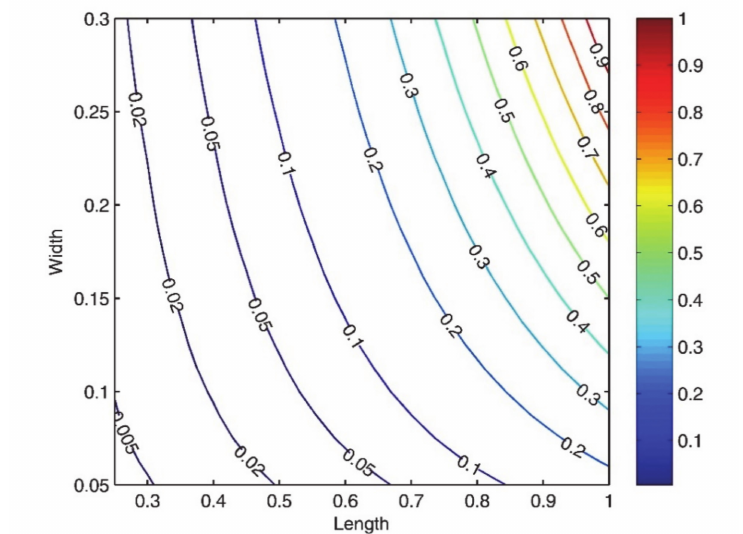
Figure 4. The relative dependence of the MFC-magnet energy harvester on its length and width for the first